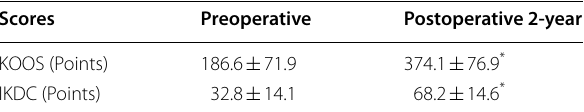
Table 4 Clinical scores based on patient-reported outcome measures